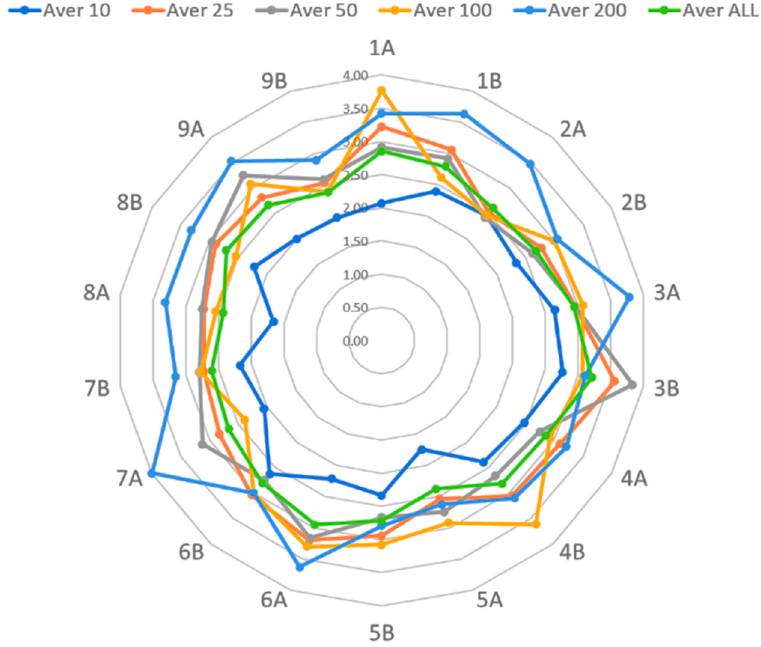
Figure 2. The average results for self-assessment in companies grouped by size.